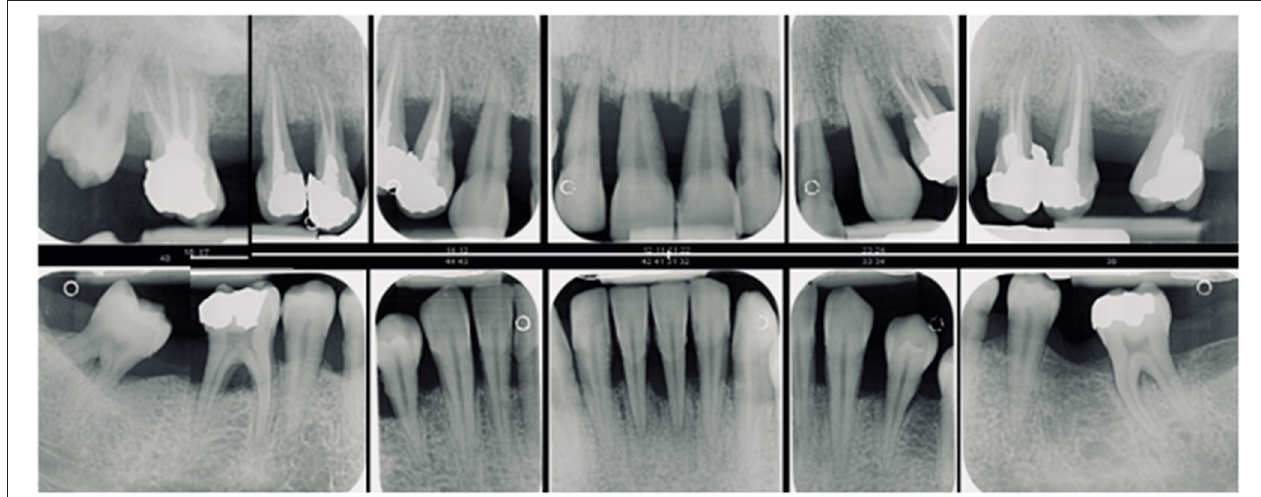
FIGURE 1 | Generalized periodontitis with early onset in a female patient aged 18 years. With a prevalence of 0.1% in white populations it is more likely to see young people with generalized complex periodontitis than an individual with a rare genetic disease. However, the detection of rare diseases increases with physicians awareness ( 7) and although the prevalence of each individual orphan disease may be low, taken together they affect up to 5% of the general population